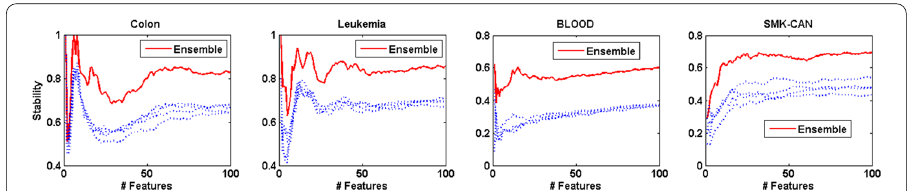
Fig. 3 Jaccard stability of Fisher Score